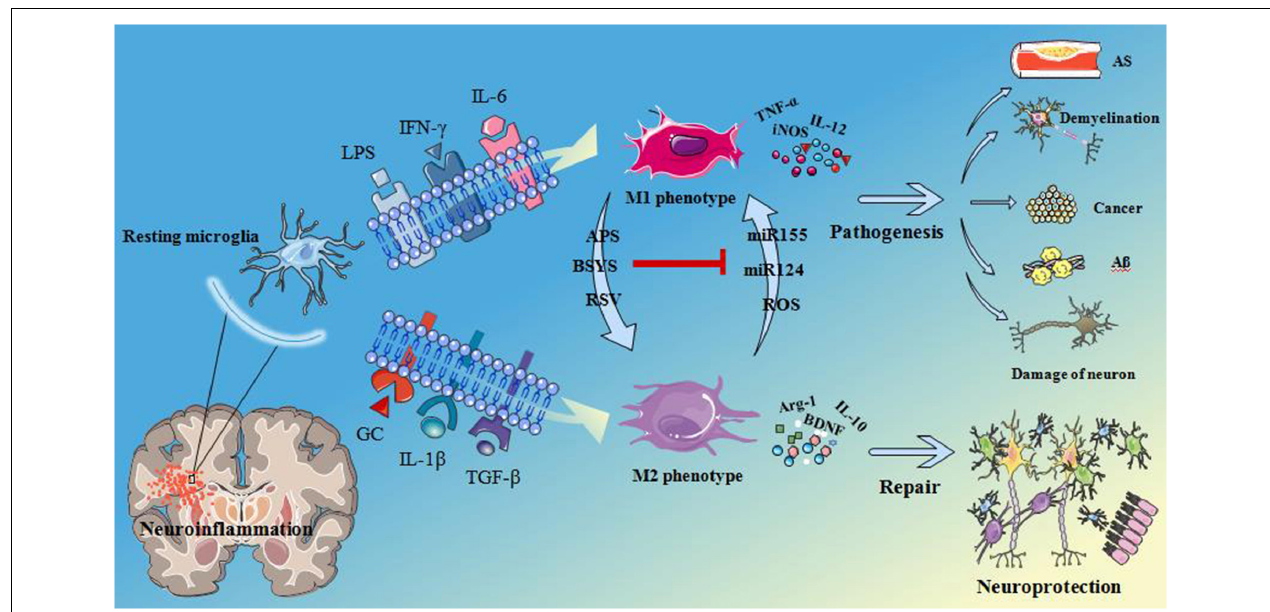
FIGURE 1 | Microglia are activated as M1 phenotype when microglia surface membrane proteins or receptors recognize LPS, INF- γ , IL-6. Then release TNF- α , inducible nitric oxide synthase (iNOS), IL-12 and other pro-inflammatory factors leading to atherosclerosis (AS), demyelination, cancer, beta amyloid (A β ) deposition and fibrillary tangles and neuronal damage. When microglia surface membrane proteins or receptors recognize glucocorticoid (GC), IL-1 β , TGF- β , etc. Microglia are activated as M2 phenotype and release arginase-1 (Arg-1), brain derived neurotrophic factor (BDNF), IL-10 these pro-inflammatory factors, play a neuroprotective role in nervous system. Astragalus polysaccharides (APS), Bu Shen Yi Sui capsule (BSYS) and resveratrol (RSV) can induce the transformation of M1 microglia into M2 microglia, On the contrary, micro ribonucleic acid 155 (miR155), miR124, and reactive oxygen species (ROS) can induce the transformation of M2 phenotype